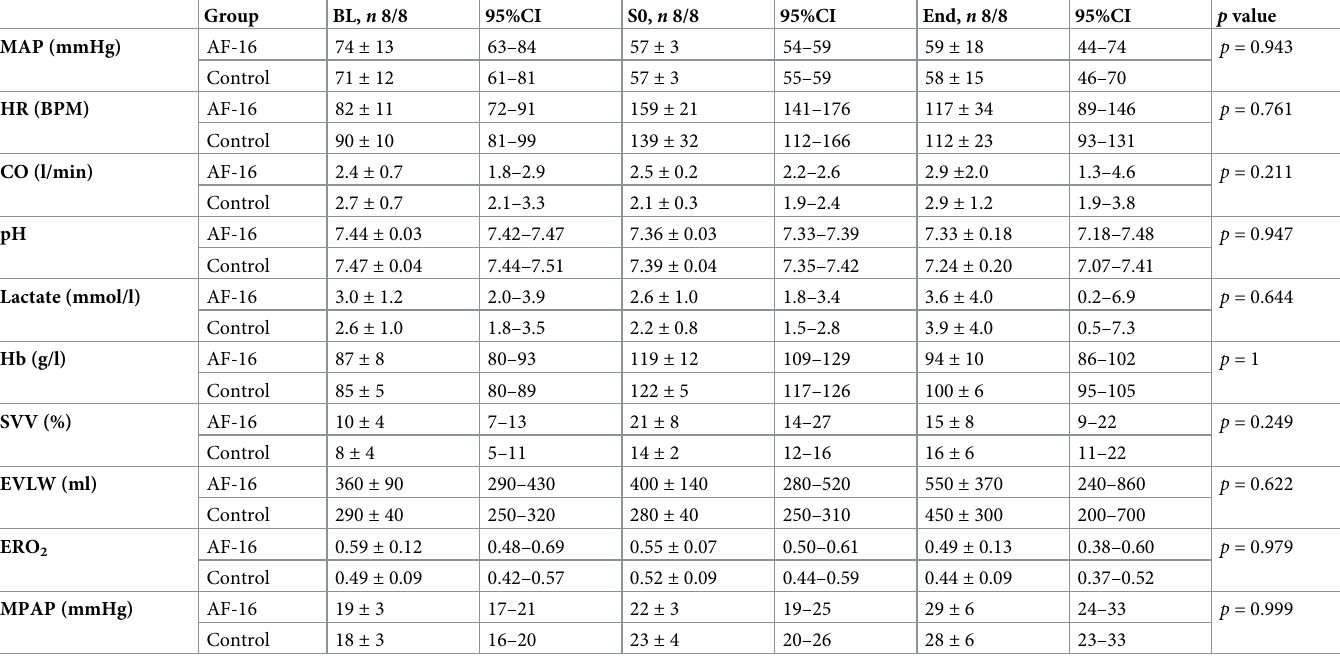
Table 3. Hemodynamic parameters, blood gas